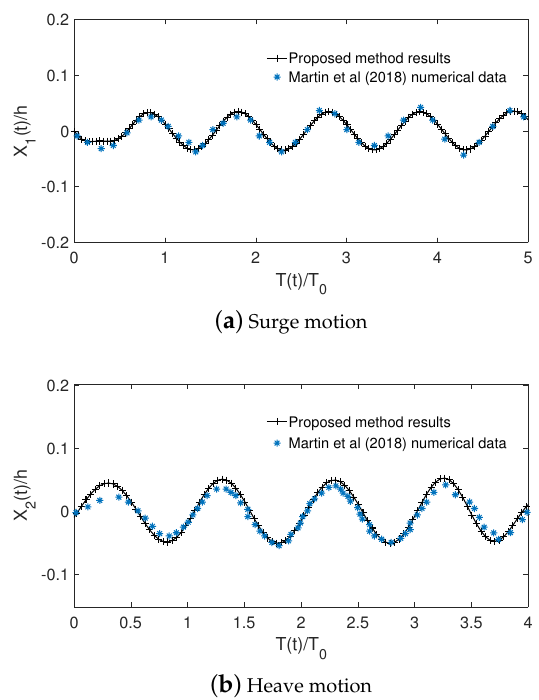
Figure 8. Comparison of time records of surge motion X 1 ( t ) ( a ) and heave motion X 2 ( t ) ( b ) between proposed method results and [35] numerical data with mooring effect